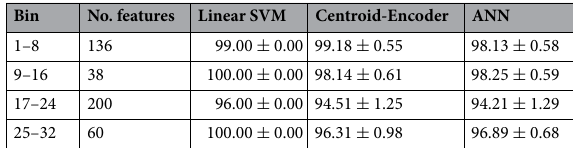
Table 2. Analysis of the influenza data using Feature Set 1 with limma normalization on study